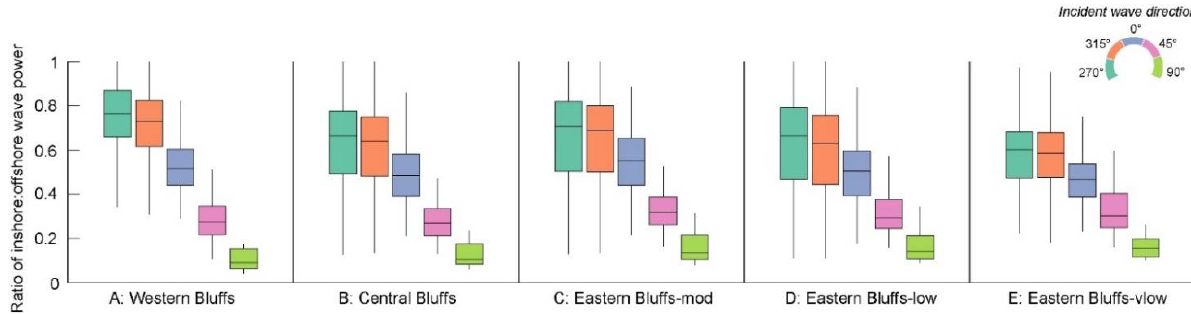
Figure 10. Ratio of inshore to offshore wave power along five distinct sections of Barter Island as a function of offshore incident wave directions. WB, EB, and CB denote the western, eastern, and central bluffs, respectively. Eastern bluff sections are further divided by moderate to very low bluff recession rates (see Figure 7a). Ratios were computed from wave model runs of 2000 individual events of varying wind and offshore wave conditions.